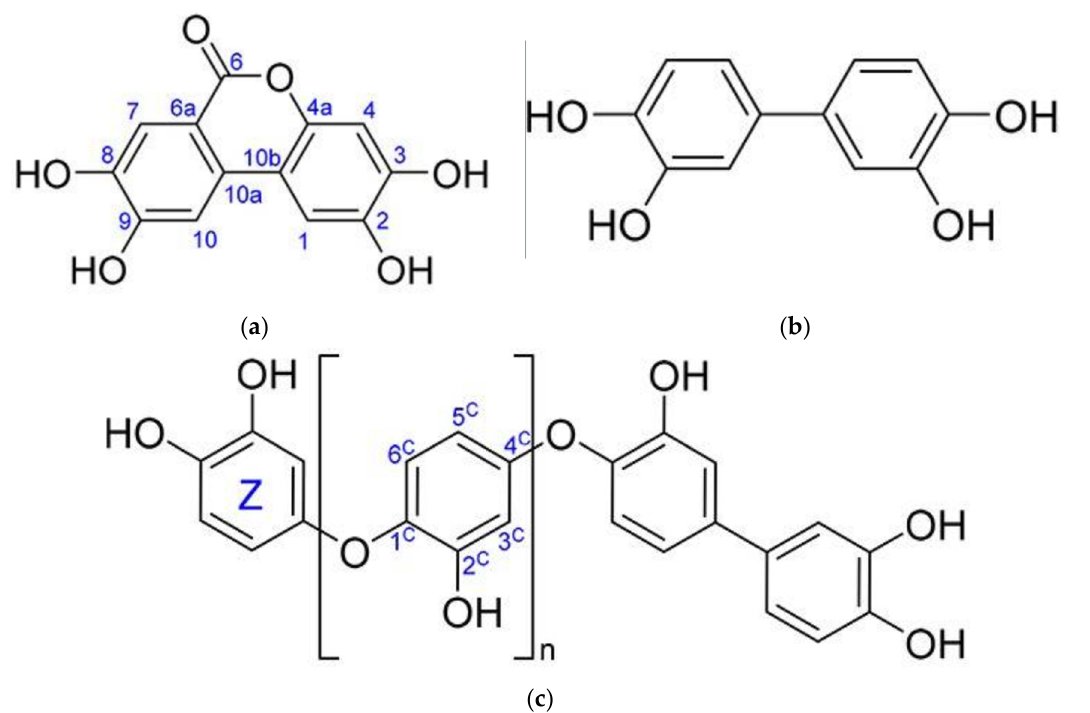
Figure 2. ( a – c ). Chemical structures of Cladophora socialis (green)-derived phenolic compounds ( a ):